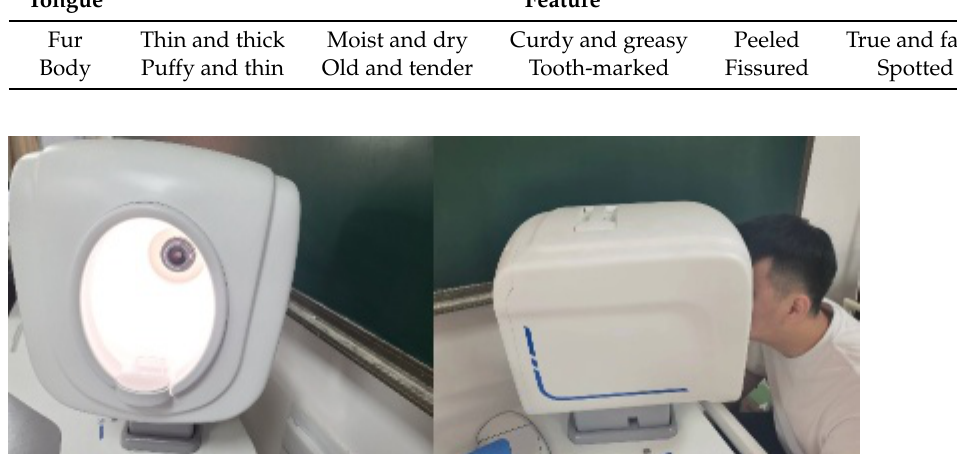
Figure 7. The device used for acquiring tongue